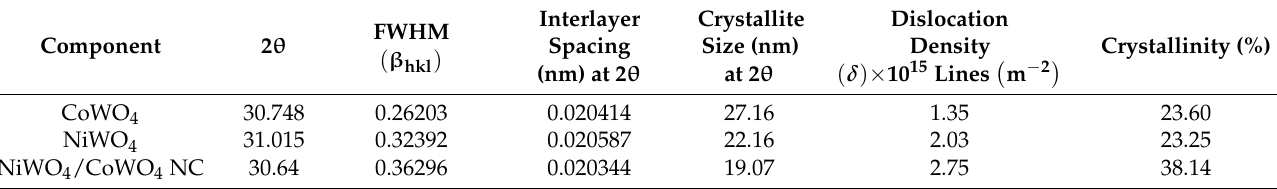
Figure 2. XRD pattern of (CoWO 4 , NiWO 4 , NiWO 4 /CoWO 4 NC) nanomaterials. Table 1. XRD parameter of CoWO 4 , NiWO 4 , and NiWO 4 /CoWO 4